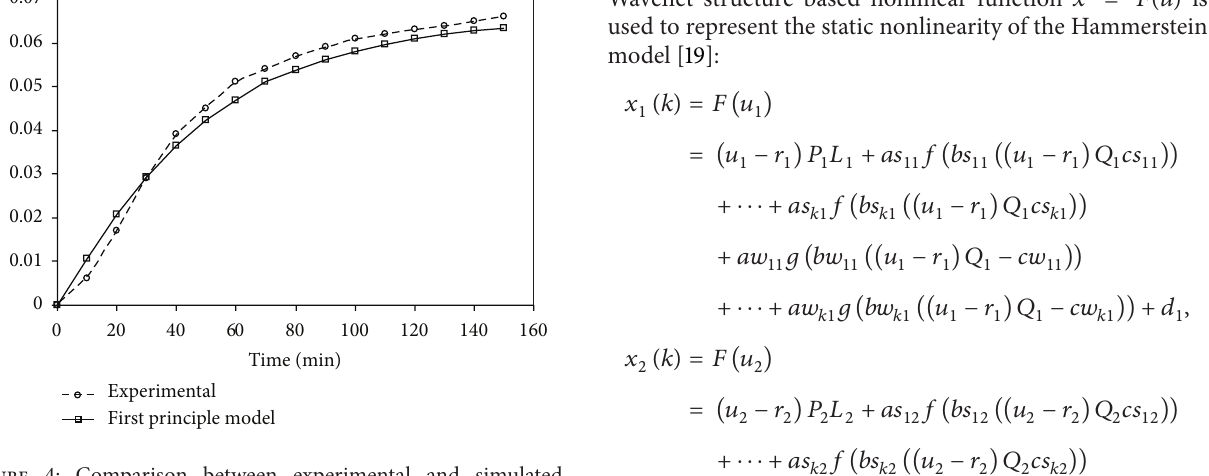
Figure 4: Comparison between experimental and simulated responses in bottom product composition for positive step change in reflux flow